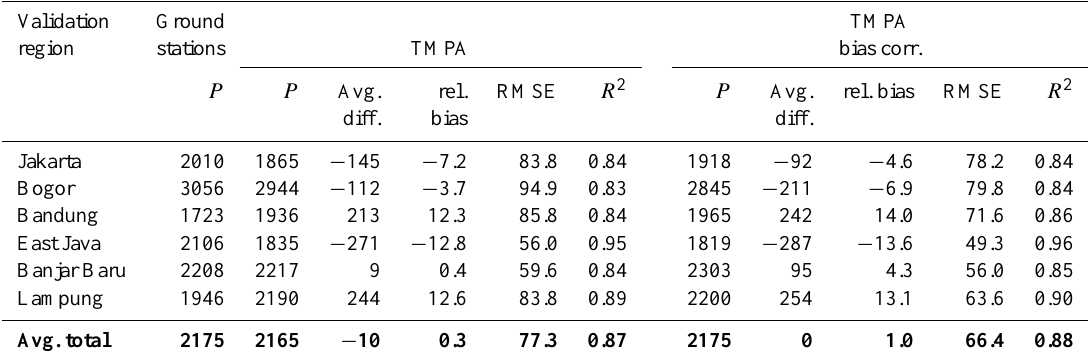
Fig. 6. Average monthly uncorrected TMPA 3B42RT (top panel) and bias corrected TMPA 3B42RT (lower panel) over 2003–2008 for all 6 validation areas together compared with ground station data (both on logarithmic axis). Table 4. Annual ground station and TMPA 3B42RT precipitation ( P , in mm per year), average difference, relative bias (%, to observations), RMSE (in mm per month) and correlation coefficients before and after bias correction of TMPA 3B42RT precipitation estimates over the period